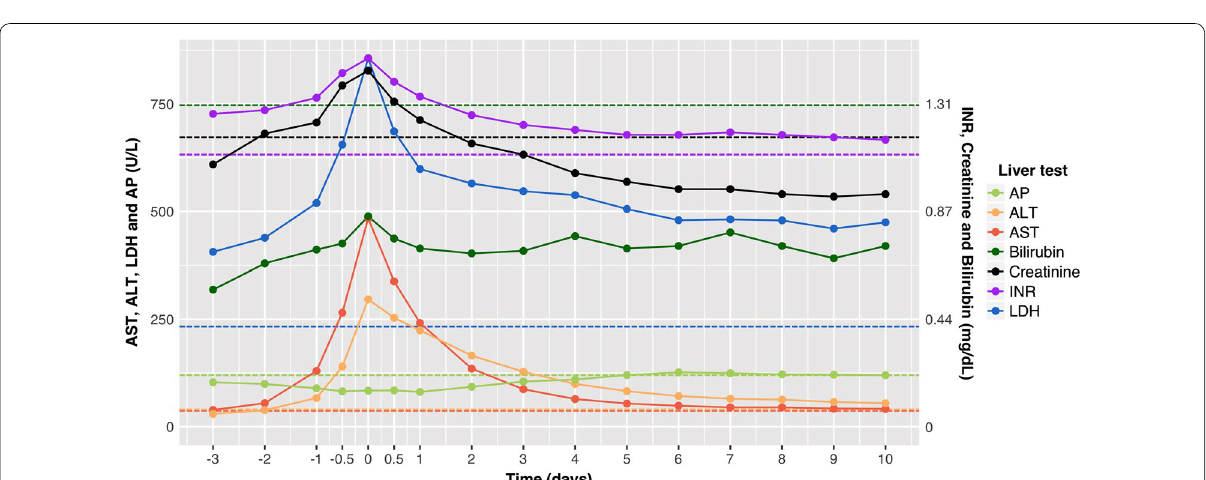
Fig. 7 Time trend of liver tests in hypoxic hepatitis of the ASTmax subgroup >20x ULN. Time trend of the median AP, ALT, AST, bilirubin, creatinine, INR and LDH levels in hypoxic hepatitis. T-ASTmax is designated as time 0. AST, ALT, LDH and AP levels are measured in U/L and are plotted using the left y-axis. Bilirubin and creatinine levels are measured in mg/dL and plotted using the right y-axis. INR has no unit, but is also plotted using the right y-axis. AP alkaline phosphatase, ALT alanine aminotransferase, AST aspartate aminotransferase, INR international normalized ratio, LDH lactate